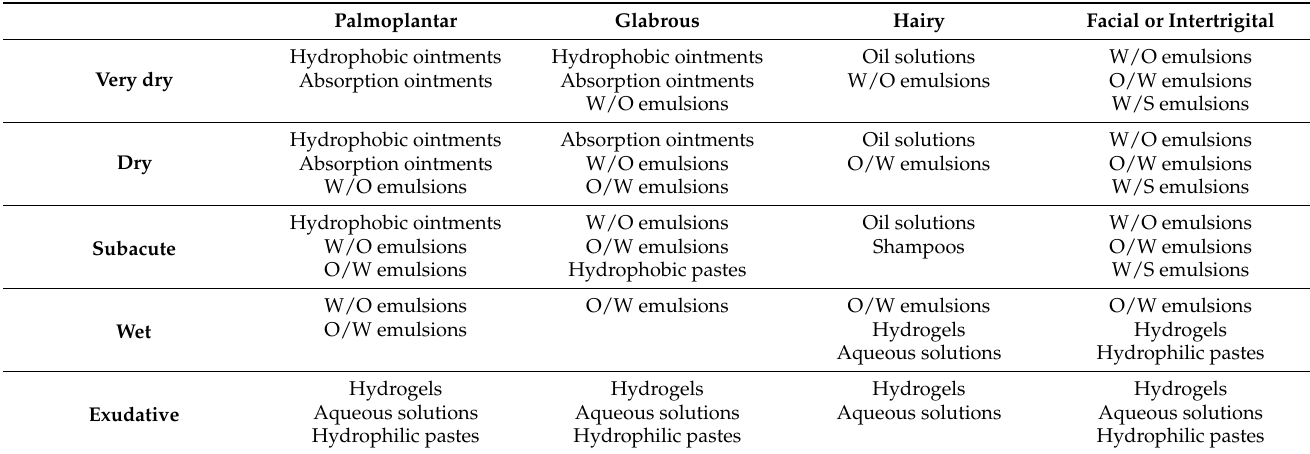
Table 3. Vehicle/base selection according to the type of lesion and body